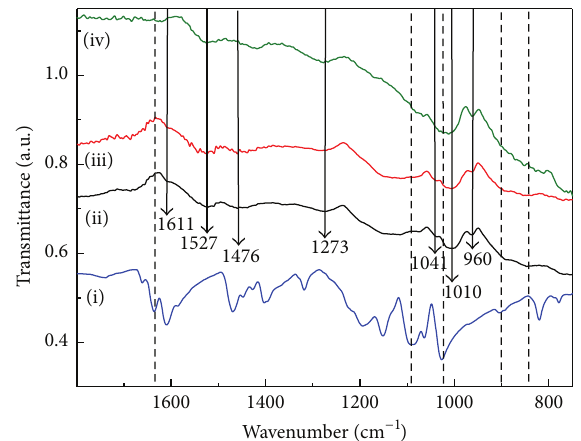
Figure 1: FTIR spectra of (i) pristine IC, (ii) PPy-IC, (iii) PPy-IC- Ag nanop , and (iv)